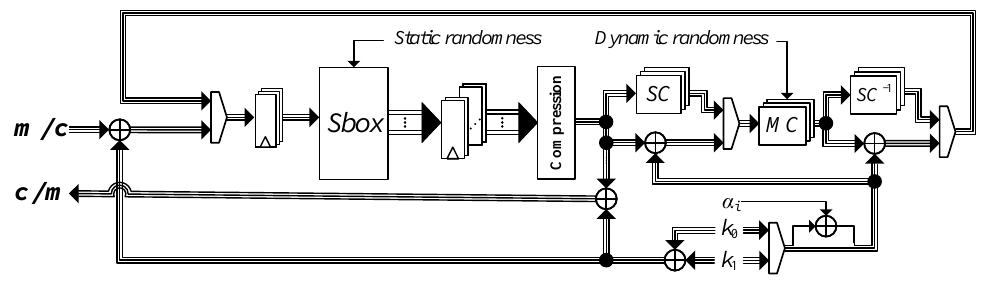
Figure 3: Design architecture of the round-based second-order secure Midori -64 encryp- tion/decryption